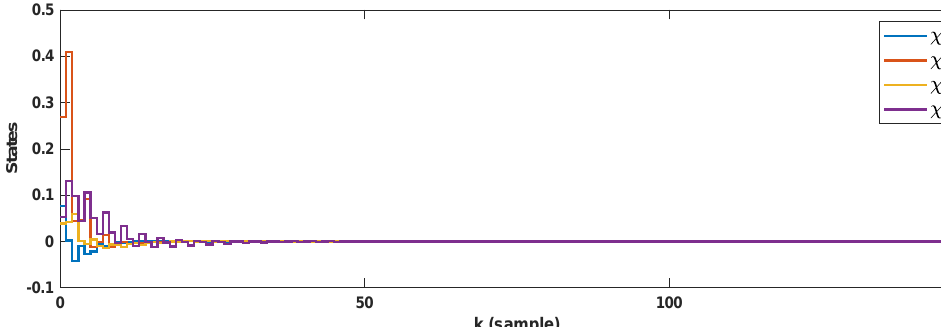
Figure 9. Example 2: Second state trajectories.